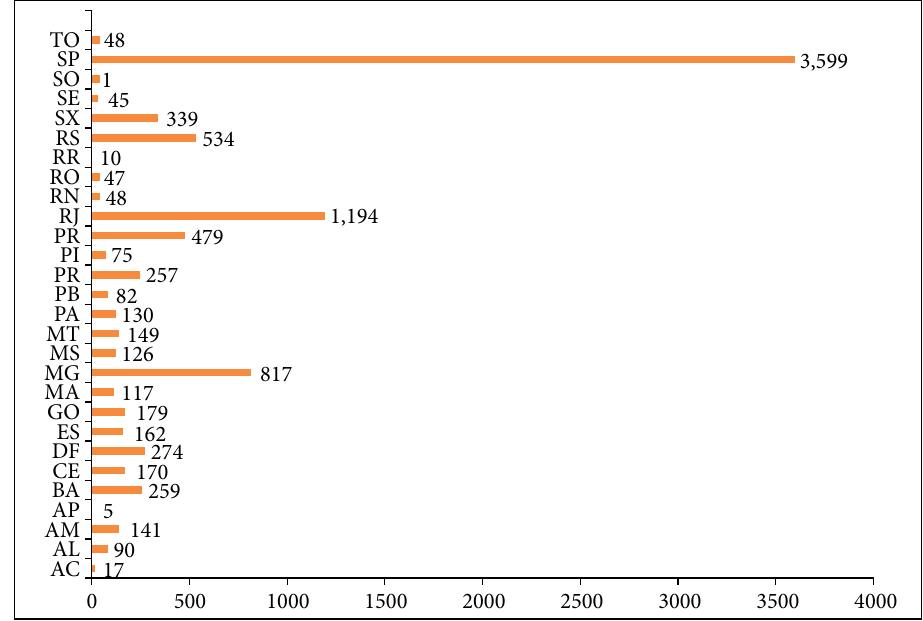
Figure 1 - Total number of Brazilian students participating in courses at IRCAD Barretos, SP, Brazil, over the 10 years and their respective states.